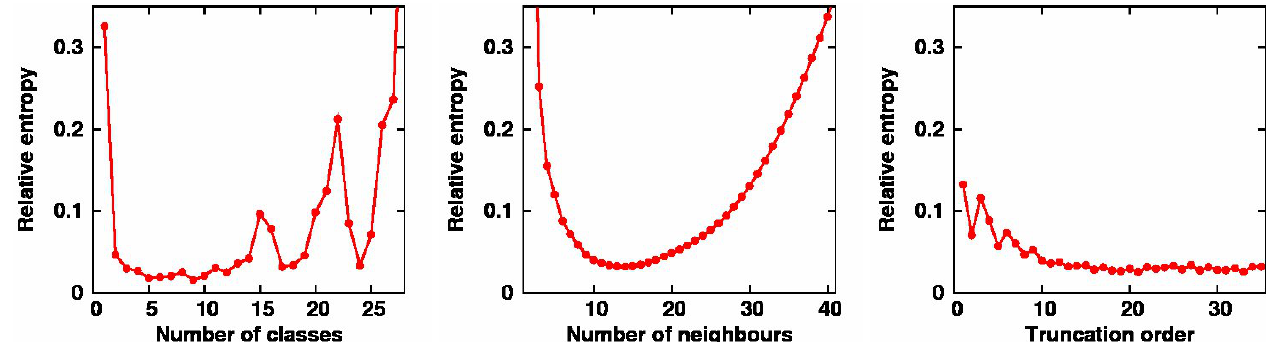
Fig. 2. Relative entropy between the transformation of the exact 0(k,θ) and N ( 0 , 1 ) , using various approximations of the transformation function: the histogram approximation (left panel), as a function of the number q of classes in the histogram, the Gaussian mixture approxi- mation (middle panel), as a function of the number q of nearest neighbours, the Hermite polynomial development (right panel), as a function of the number q of superposed polynomials. In all 3 cases, the relative entropy is computed by numerical integration over the same interval | z | < 2 . 576, except in the 3rd case (polynomial development) for which the subintervals with zero density (due to the non-bijectivity of the approximation) have been